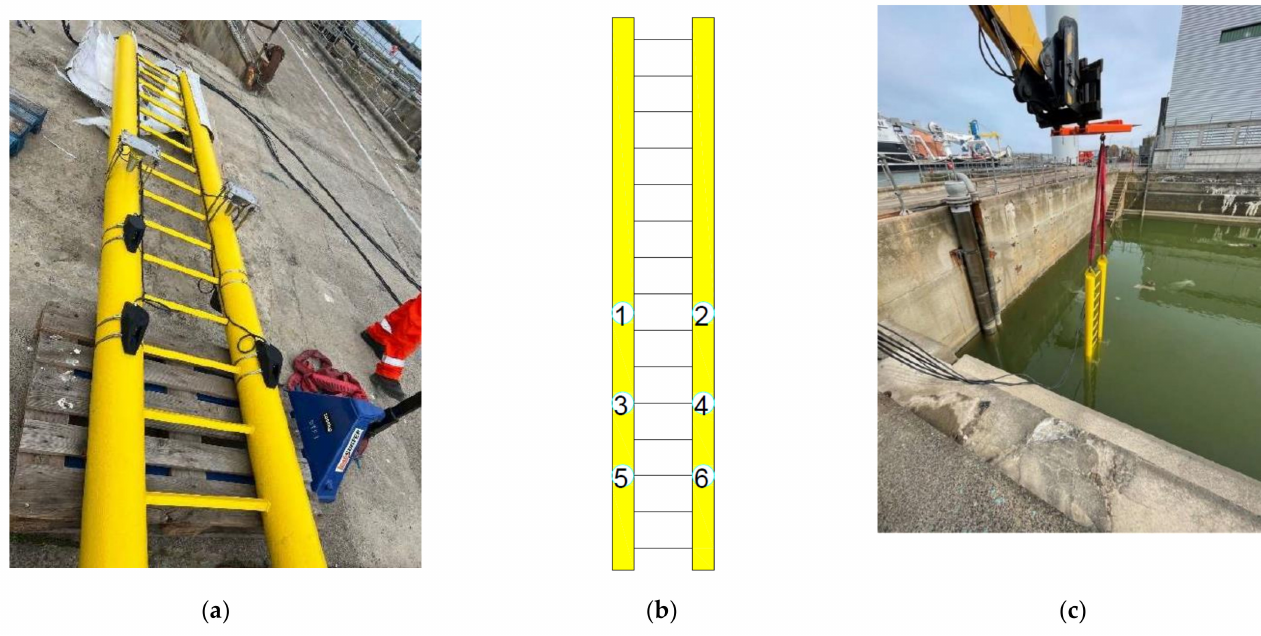
Figure 11. Preparing the test rig, ( a ) attached transducer to the ladder with ( b ) their corresponding number and ( c ) suspending the ladder into a pool—courtesy of Offshore Renewable Energy,